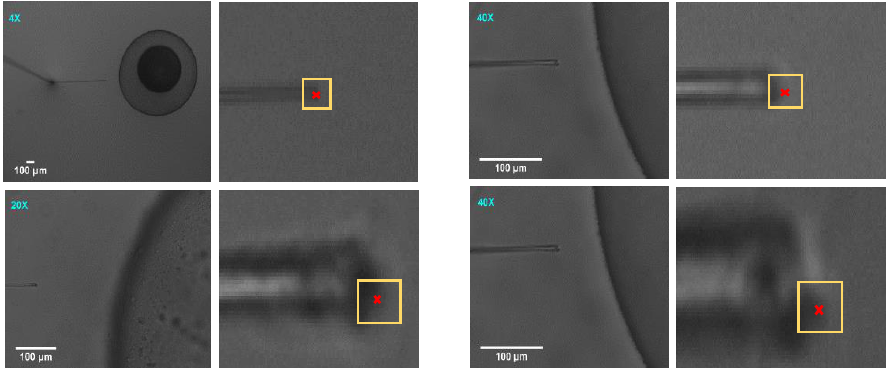
Figure 9. Pixel selection by ImageJ software.